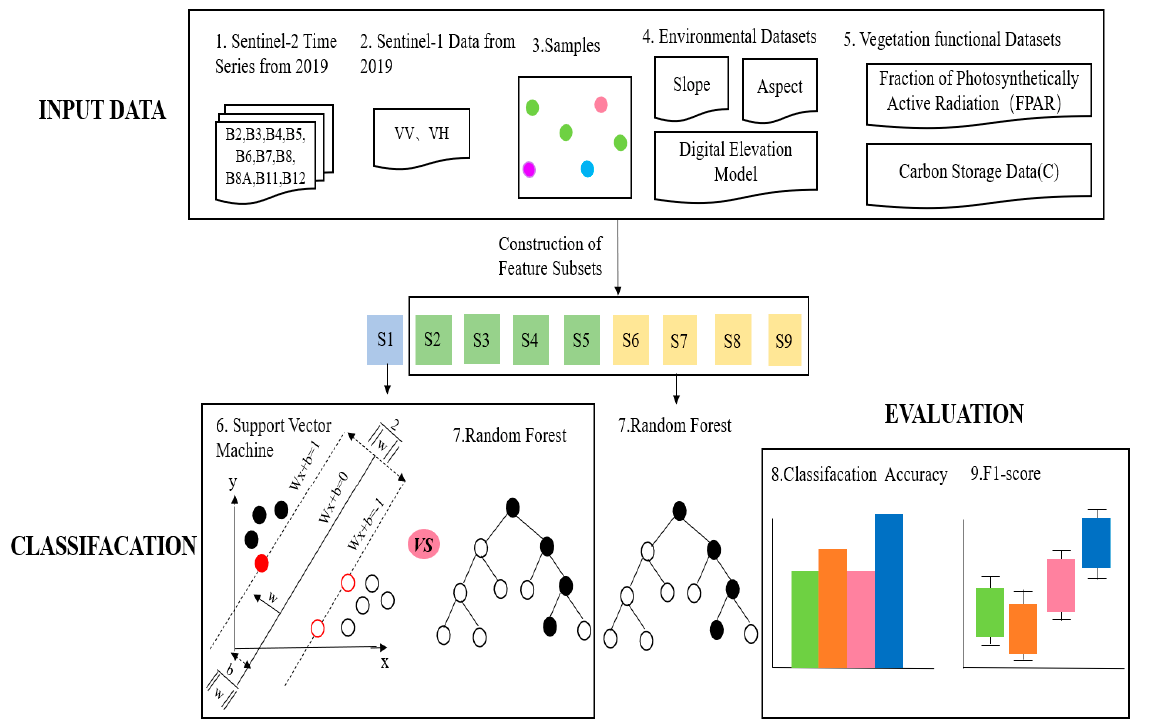
Figure 4. Flow chart of the overall experiment. Table 2. Summary table of vegetation indices selected in this